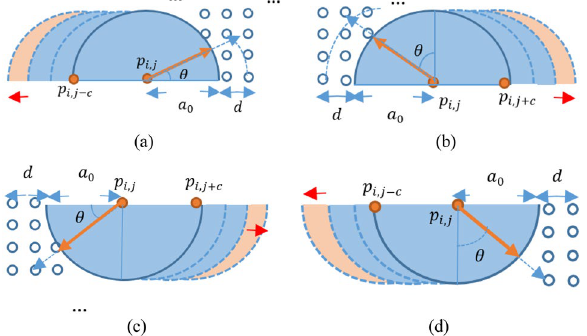
Figure 3. A schematic for p i,j and its roundish neighborhood in ( a ) top-right and ( b ) top-left, ( c ) bottom-left and ( d ) bottom-right